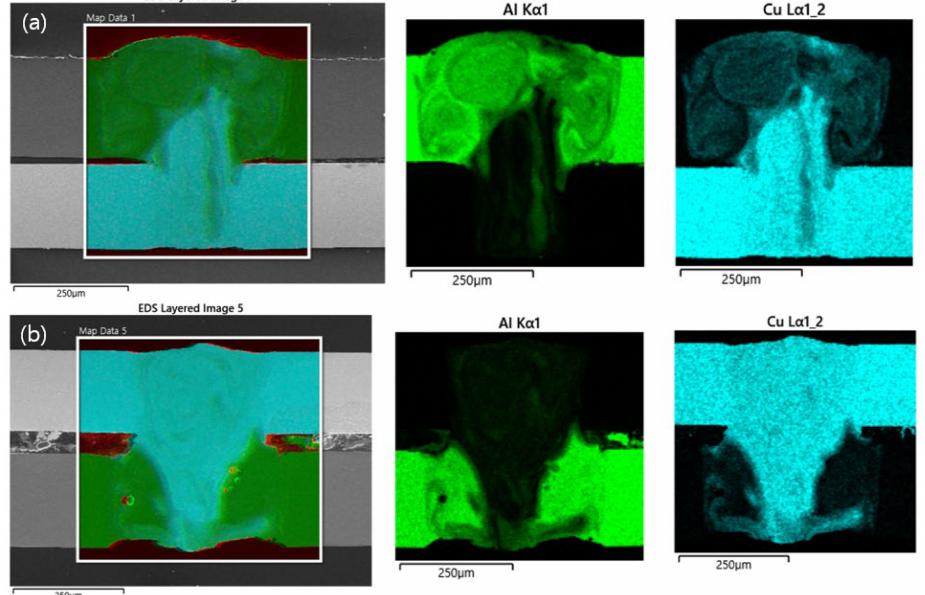
Figure 3. Energy-dispersive X-ray spectroscopy (EDS) mapping images for the joint cross-sections showing the distributions of Al and Cu after welding at a speed of 400 mm/s. ( a ) Using Al as the upper materials, and ( b ) using Cu as the upper